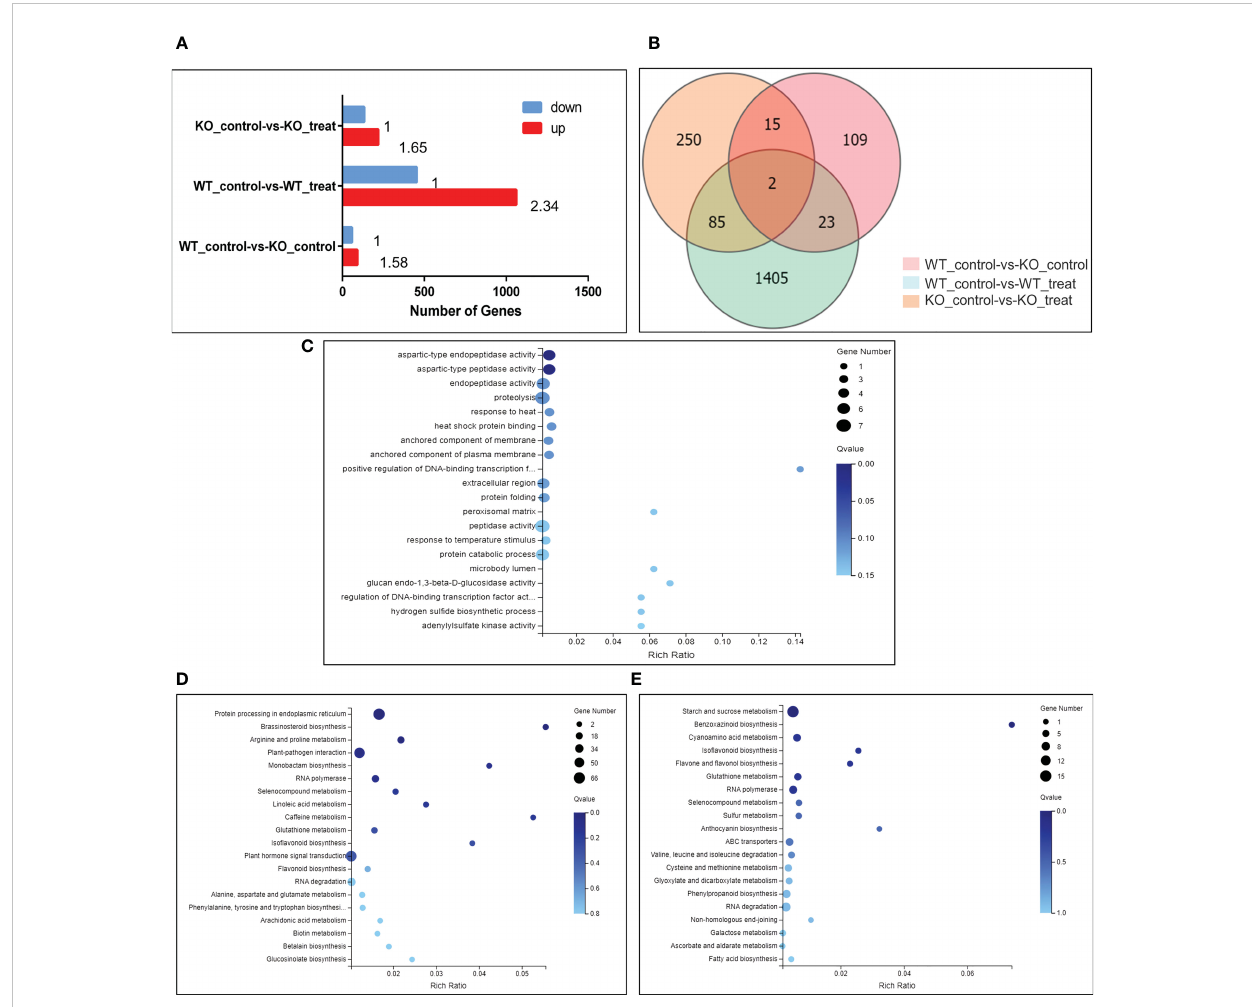
FIGURE 4 Changes in gene expression pro fi les of N. benthamiana (WT and KO) in response to PVY infection. (A) Several DEGs in pairwise comparisons of the 2 treatments. Qvalue (Adjusted Pvalue) <= 0.05. (B) Venn diagram showing the number of DEGs for different treatments. Qvalue (Adjusted Pvalue) <= 0.05. (C) Go enrichment map showing concentrations of DEG numbers of 85 genes that co-express differentially between the 2 treatments. Qvalue (Adjusted Pvalue) <= 0.05. (D) KEGG enrichment map showing concentrations of DEGs of WT_control-vs-WT_treat group. Qvalue (Adjusted Pvalue) <= 0.05. (E) KEGG enrichment map showing concentrations of DEGs of KO_control-vs-KO_treat group. Qvalue (Adjusted Pvalue) <=